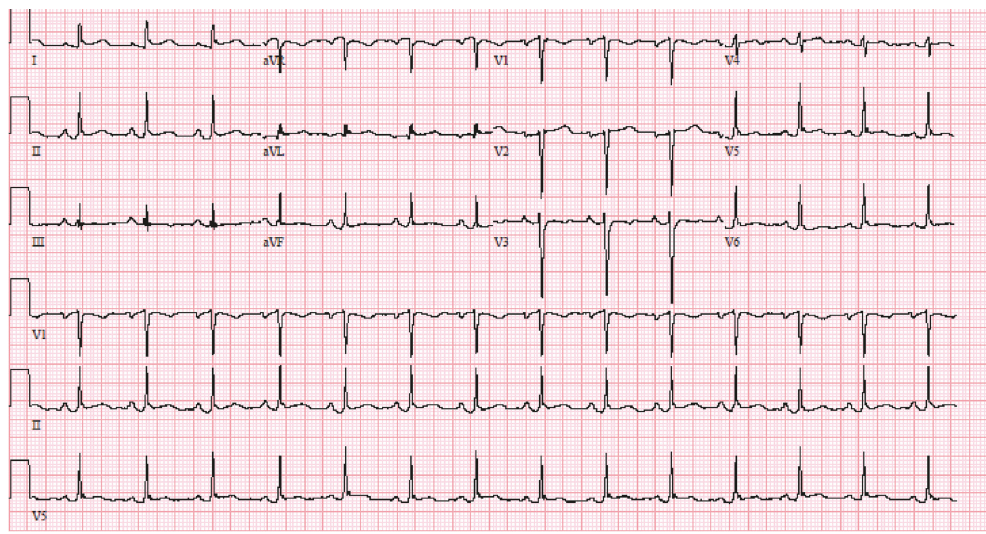
Figure 5: ECG postoperative day 3 showing resolution of ST elevation and T wave inversions in leads